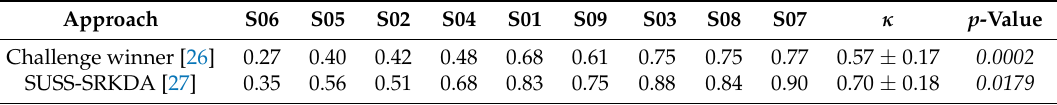
Table 1. Mean kappa scores attained by compared approaches at each subject from the BCICIV2a dataset. The last two columns present the average kappa and the t -test p -value between Multi-Kernel Stein Spatial Patterns (MKSSP) and the corresponding approach. In bold highest kappa values, in italic p -values <